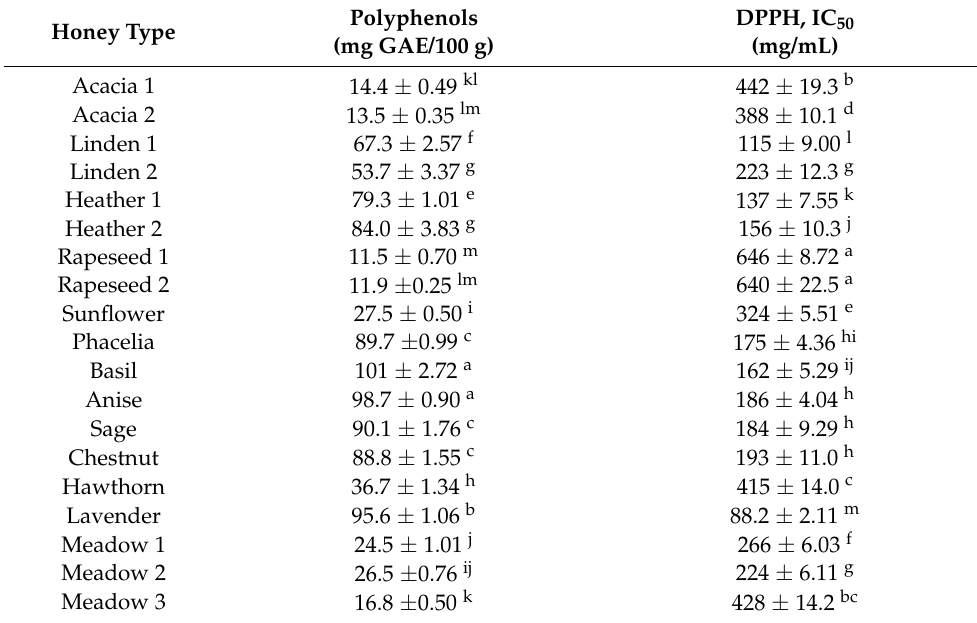
Table 3. Phenolic content and DPPH radical scavenging activity of different types of honey. Honey